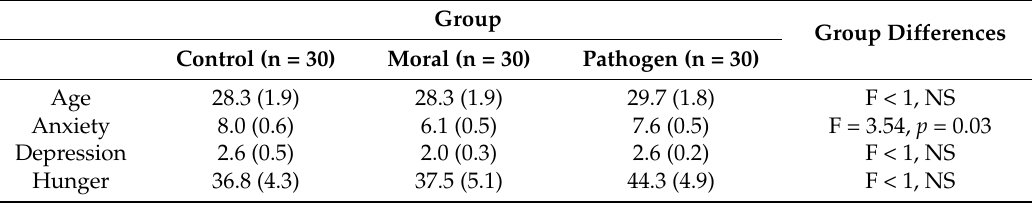
Table 1. Mean (SE) Participant Characteristics (Experiment